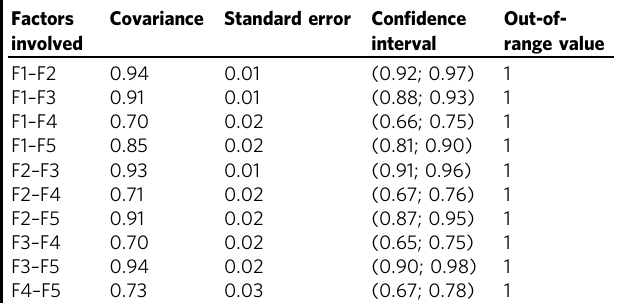
Table 4 Discriminant